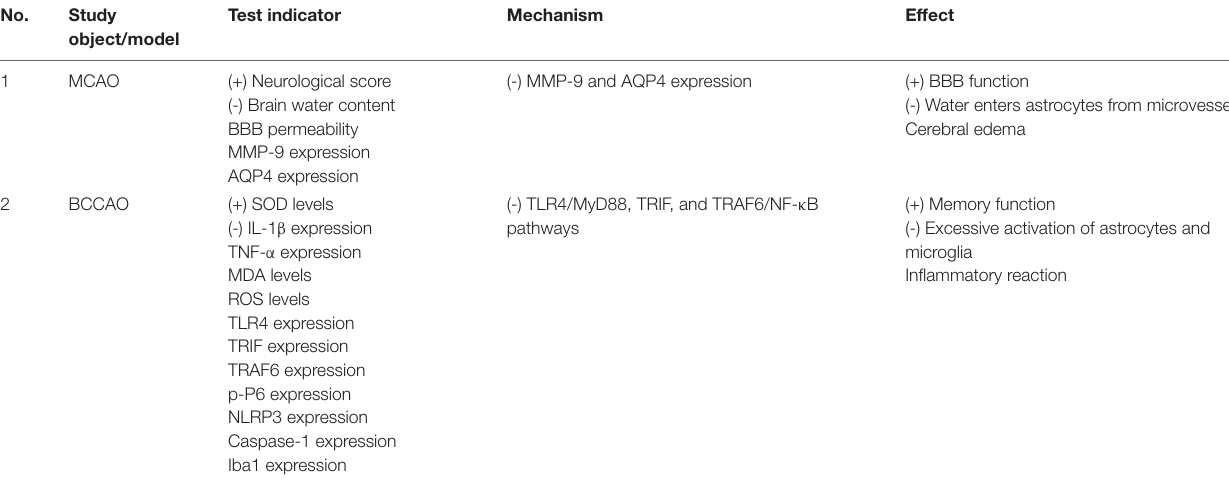
TABLE 2 | Protective effect and mechanism of astragaloside IV against cerebral ischemia-reperfusion complications.